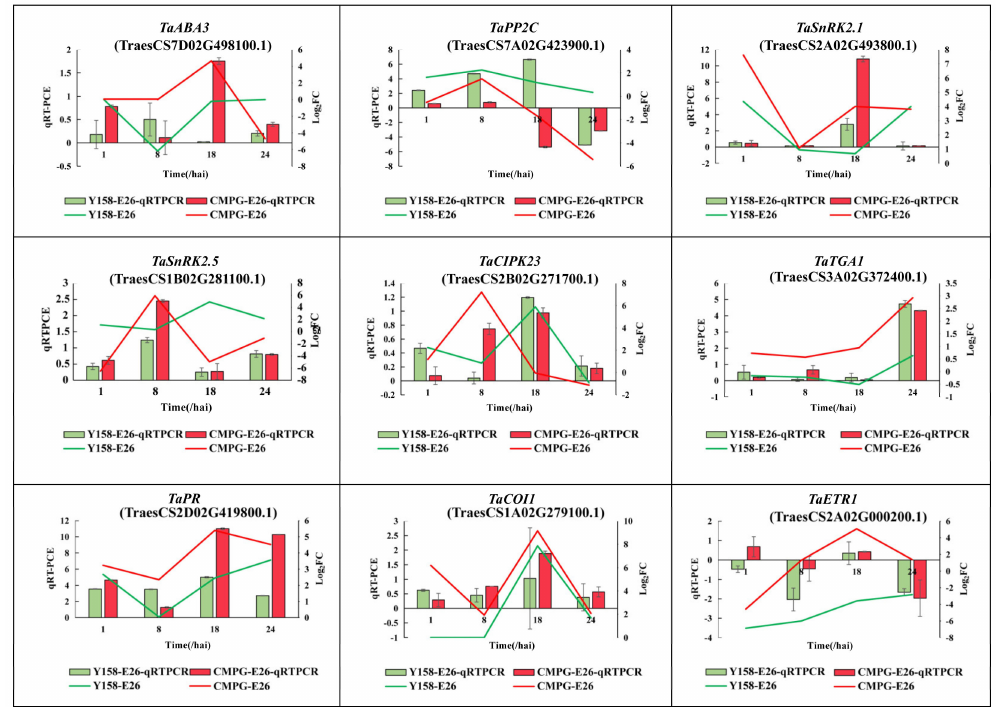
Figure 5. qRT-PCR and sequencing data of genes expression in CMPG1-V OE and susceptible receptor Yangmai 158 from 1 hai to 24 hai after Bgt infection. The histogram represents qRT-PCR of genes expression. Green represents Yangmai 158, red represents CMPG1-V OE . Line chart represents sequencing data of genes expression. The green line represents Yangmai 158, red line represents CMPG1-V OE